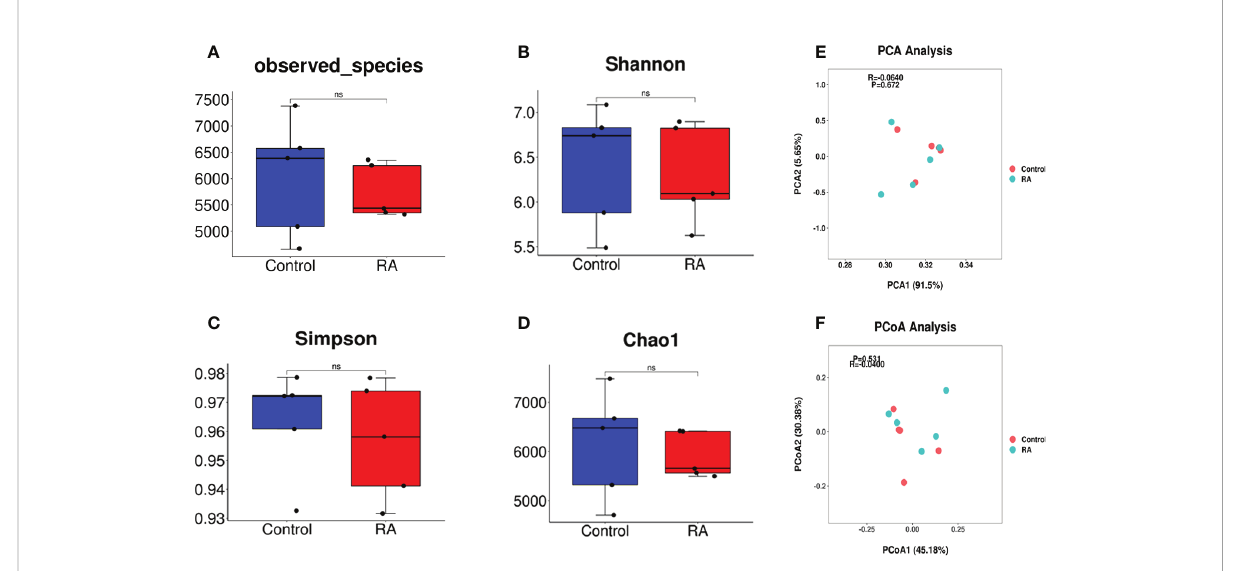
FIGURE 2 Gut microbiome diversity and structure analysis. (A-D) Alpha diversity differences between the RA and control groups were estimated by the observed species (A) , Shannon (B) , Simpson (C) , and Chao1 (D) indices. NS, not signi fi cant. (E, F) Beta diversity differences between the RA and control groups were estimated by the PCA (R=-0.0640, P=0.672) (E) and PCoA (R=-0.04, P=0.531) (F) of the microbiota (P and R value by ANOSIM analysis, -1 ≤ R ≤ 1, p<0.05 were considered statistically signi fi